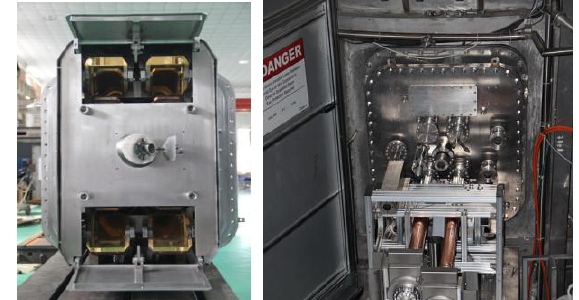
Fig.11. Photos of the launcher plug-in